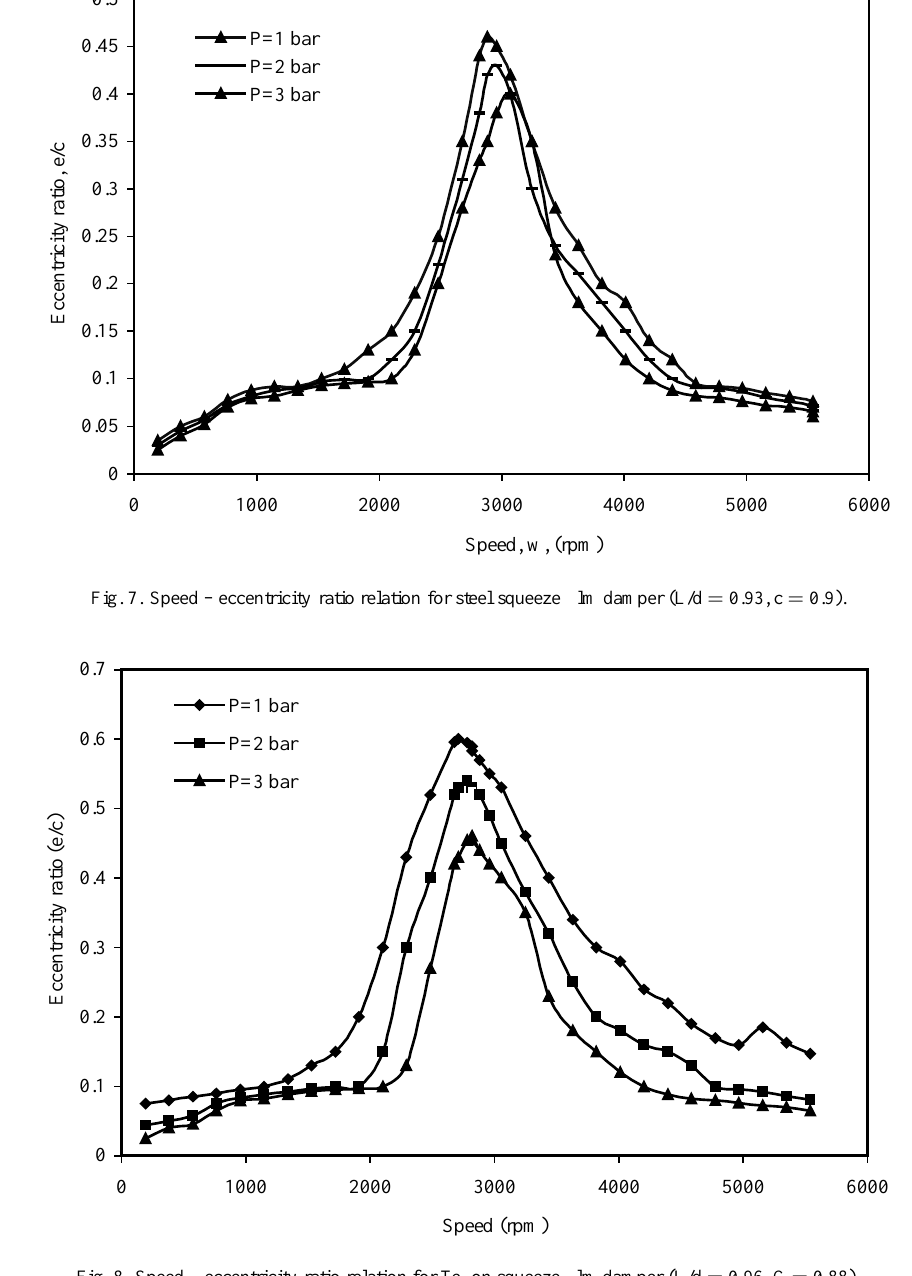
Fig. 8. Speed – eccentricity ratio relation for Teflon squeeze film damper (L/d = 0.96, C =